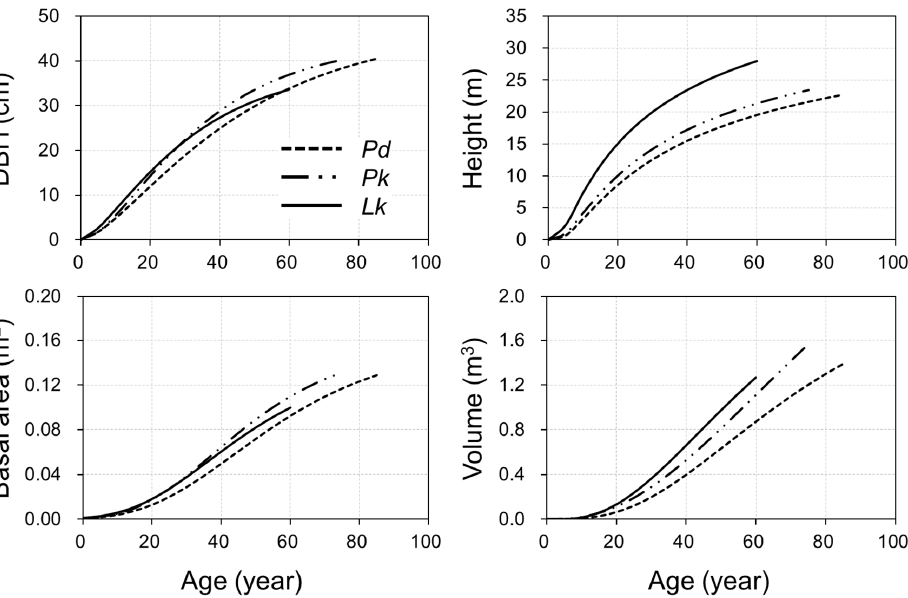
Figure 3. Predicted growth curves of DBH, height, basal area, and stem volume for species within the age range of modeling data. The best models by variables are based on fit statistics and model performance of the results; the selected growth functions are Chapman-Richards for DBH and stem volume, Korf for height, and Gompertz for basal area. Pd : Pinus densiflora . Pk : Pinus koraiensis . Lk : Larix kaempferi .